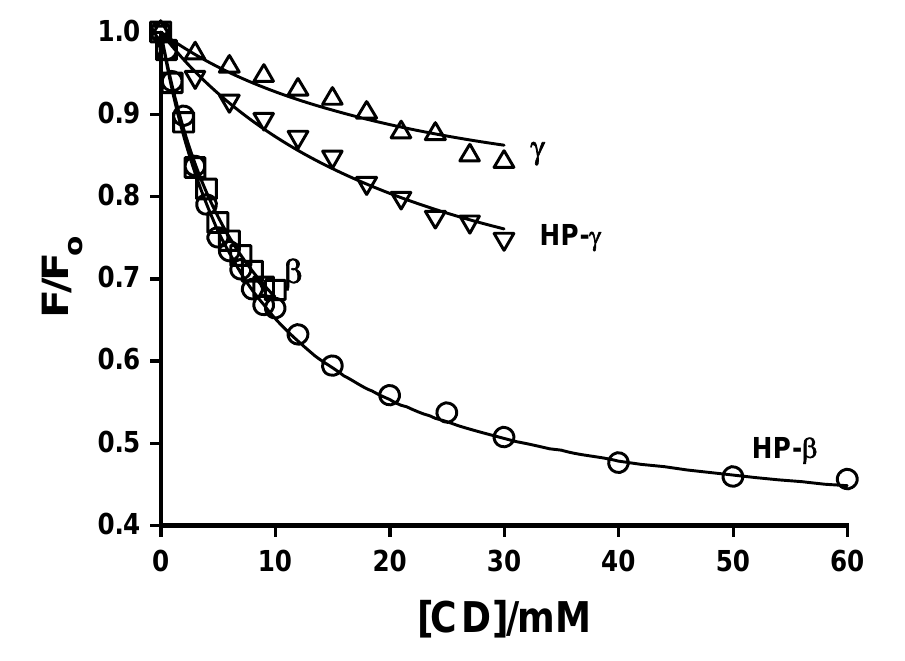
Figure 8 . The effect of cyclodextrin concentration on the relative total fluorescence (F/F of 7-methoxycoumarin ( λ = 320 nm) for various cyclodextrins: (cid:133) β -CD, (cid:123) HP- β -CD, Δ ex γ -CD, ∇ HP- γ -CD; the solid lines show the fit to a 1:1 host:guest complex model. Reproduced from Reference 45 (Figure 3, © 2003 Kluwer Academic Publishers), with kind permission of Springer Science and Business